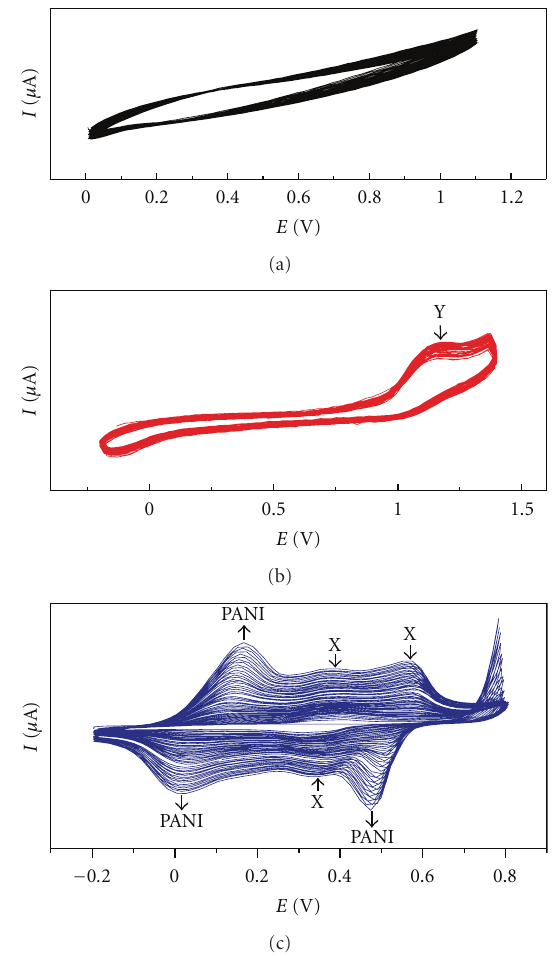
Figure 1: Cyclic voltammograms of PANI-Co(II)TATPP film electrodeposition on Pt WE from (a) acetonitrile; (b) DMF; (c) DMF: 0.5/L M aniline in 1M/L H 2 SO 4 = 1:1. The working and counterelectrodes were platinum, and the scan rate was 0.1 V/s. On figure X corresponds to incorporation of Co(II)TATPP in film; Y indicates the decrease of current and insulating film formation.